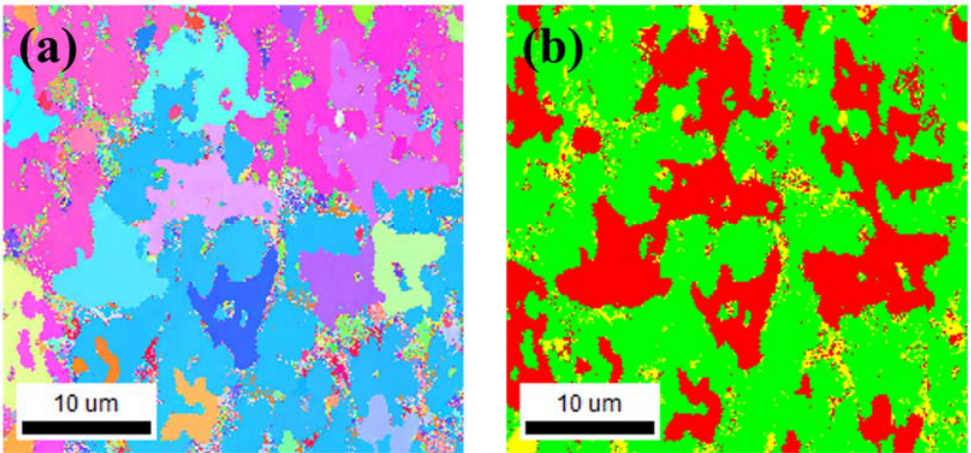
Figure 8. The EBSD results of the Ti ‐ Nb ‐ Cr ‐ V ‐ Ni ‐ Al: ( a ) IPF map and ( b ) phase map (red = BCC A2, green = σ , and yellow = Ti 2 Ni).